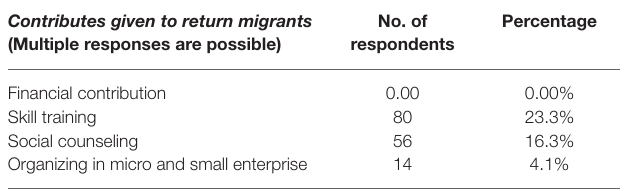
TABLE 4 | Challenges facing female return migrants in post returning to Ethiopia. Challenges after coming to Ethiopia (Multiple responses are possible)